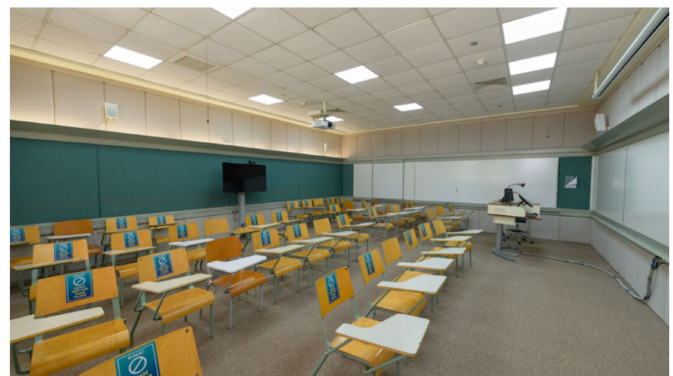
Figure 2. Standard Classroom at the American University in Cairo fitted with carpets and full padding for dual-delivery. Courtesy of AUC.